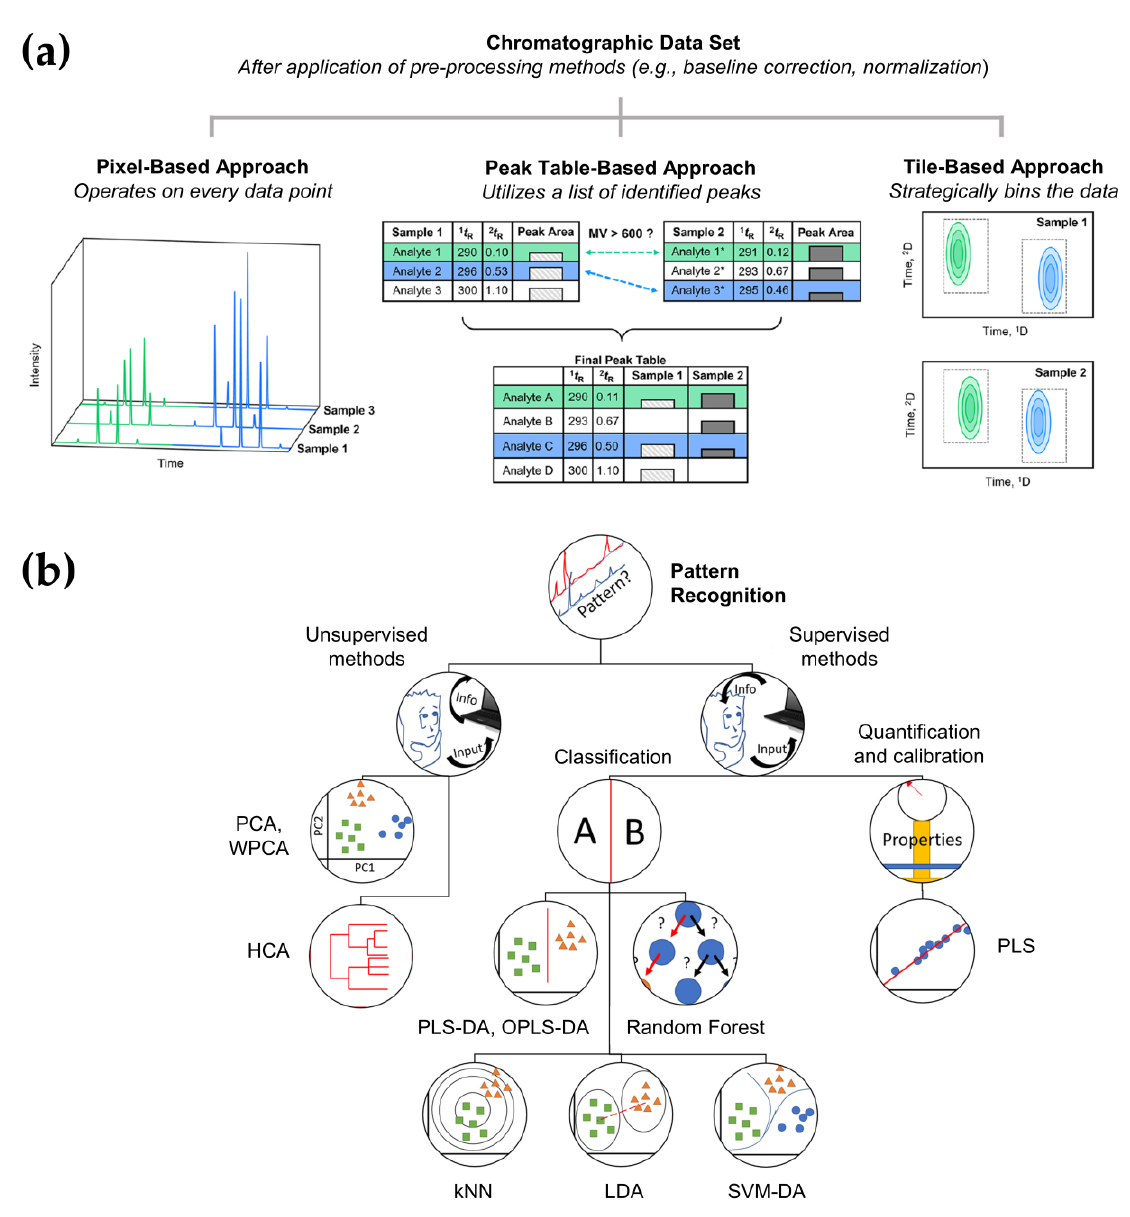
Figure 1. Application of several GC×GC data pre(processing) methods: ( a ) retention time alignment approaches, adapted with permission from Ref. [123]. Copyright © 2023 by the authors; American Chemical Society, Washington, DC, United States; and ( b ) chemometrics techniques, adapted with permission from Ref. [131]. Copyright © 2023 by the authors; Elsevier B.V., Amsterdam, The Netherlands.